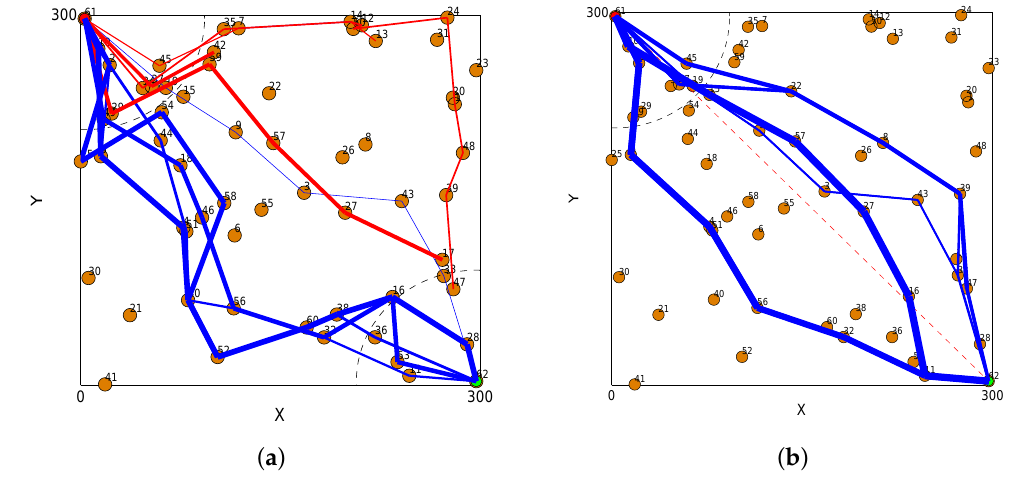
Figure 5. Accumulated routing path corresponding to ( a ) EHWA and ( b ) SAGREH after transmitting 15 packets.